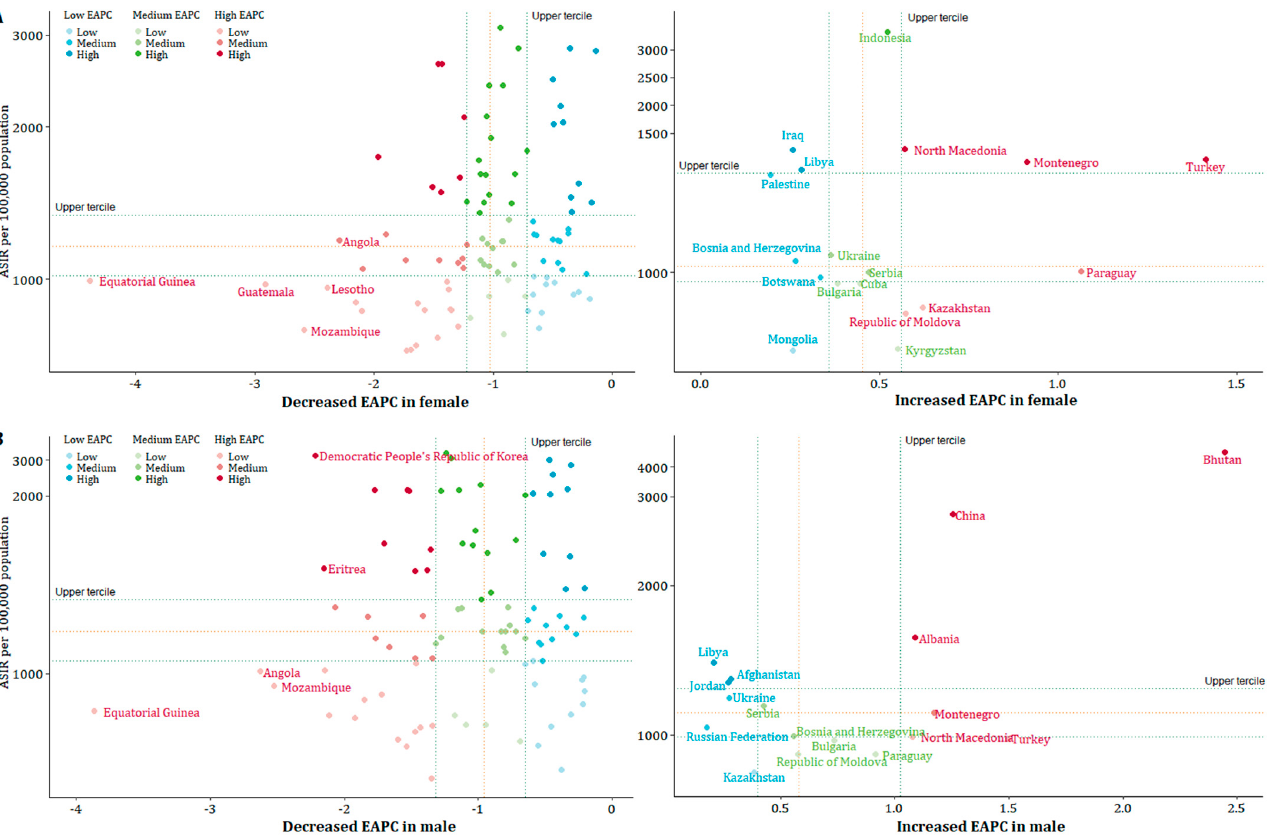
Figure 5. Age-standardized incidence rate in 2019 and its estimated annual percentage change in 1990–2019 due to nutritional deficiencies for all ages stratified by sex at national levels in LMICs. ( A ) Female; ( B ) male. Note: Dots represent countries, color-coded according to quadrants defined by lower and upper terciles (33 and 66 percentiles) of the distribution of countries according to the ASIR per 100,000 population and the estimated annual percentage change of the ASIR per 100,000 population in 1990–2019. The countries marked in the figure represent the top five countries with the fastest decline per year and all countries with increased trend.